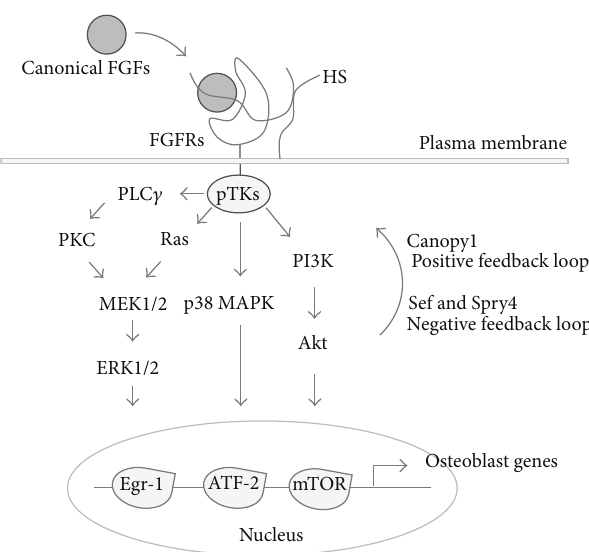
Figure 1: FGF/FGFR signaling and its feedback loops. Ligand- dependent activation of FGFR tyrosine kinases induces ERK1/2, p38 MAPK, and Akt phosphorylation and subsequent upregu- lation of their downstream transcriptional factors such as early growth response protein-1 (Egr-1), activating transcriptional factor- (ATF-) 2, and mammalian target of rapamycin (mTOR). These transcription factors regulate the expression of genes involved in osteoblastogenesis. Canopy1 acts as positive feedback factor for FGF/FGFR signaling. Sef and Spry4 silence FGF/FGFR signaling. pTKs: phosphorylated tyrosine kinases; PLC 𝛾 : phospholipase C 𝛾 ; PKC: protein kinase C; MEK: mitogen-activated protein kinase; PI3 K: phosphoinositide